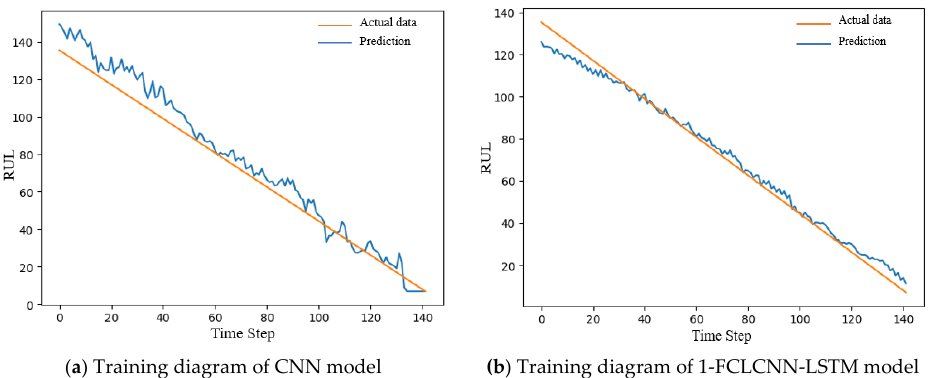
Figure 12. Training diagram of the same FD001 engine under two models.